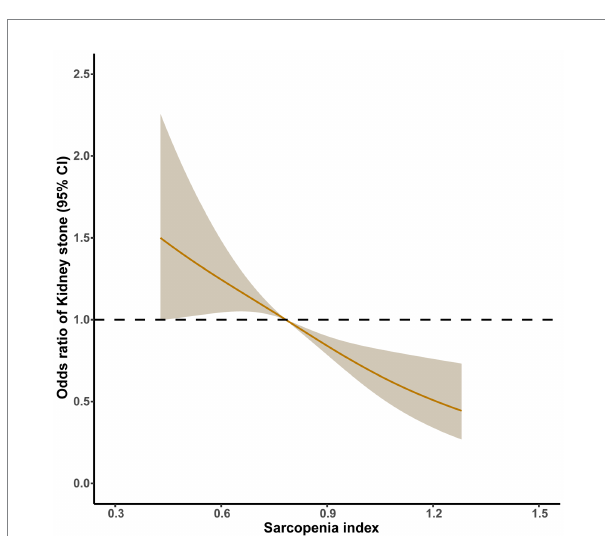
FIGURE 4 Relative risk for kidney stones based on sarcopenia index after PSM. The shaded areas represent upper and lower 95% CIs. Adjustment factors are as same as which presented in extended model 4. Restricted cubic spline (RCS) plot of the association between sarcopenia index and kidney stones. The solid and dashed lines represent the odds ratios and 95% confidence intervals.